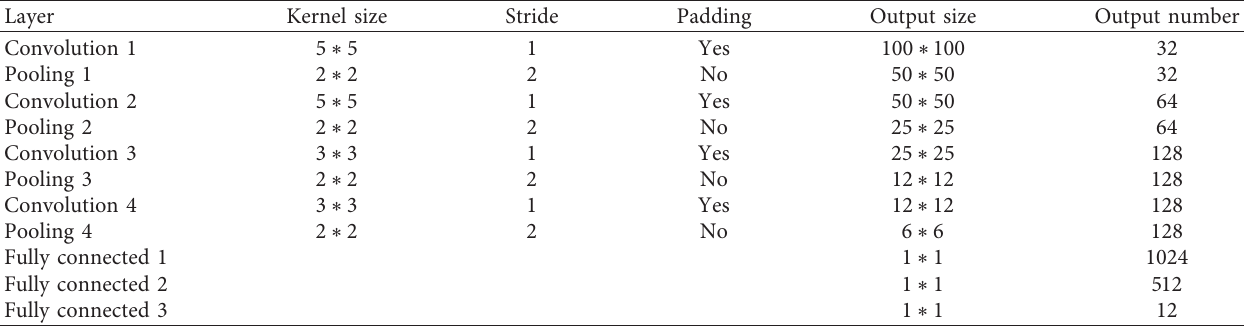
Table 2: Details of the proposed CNN model used in the